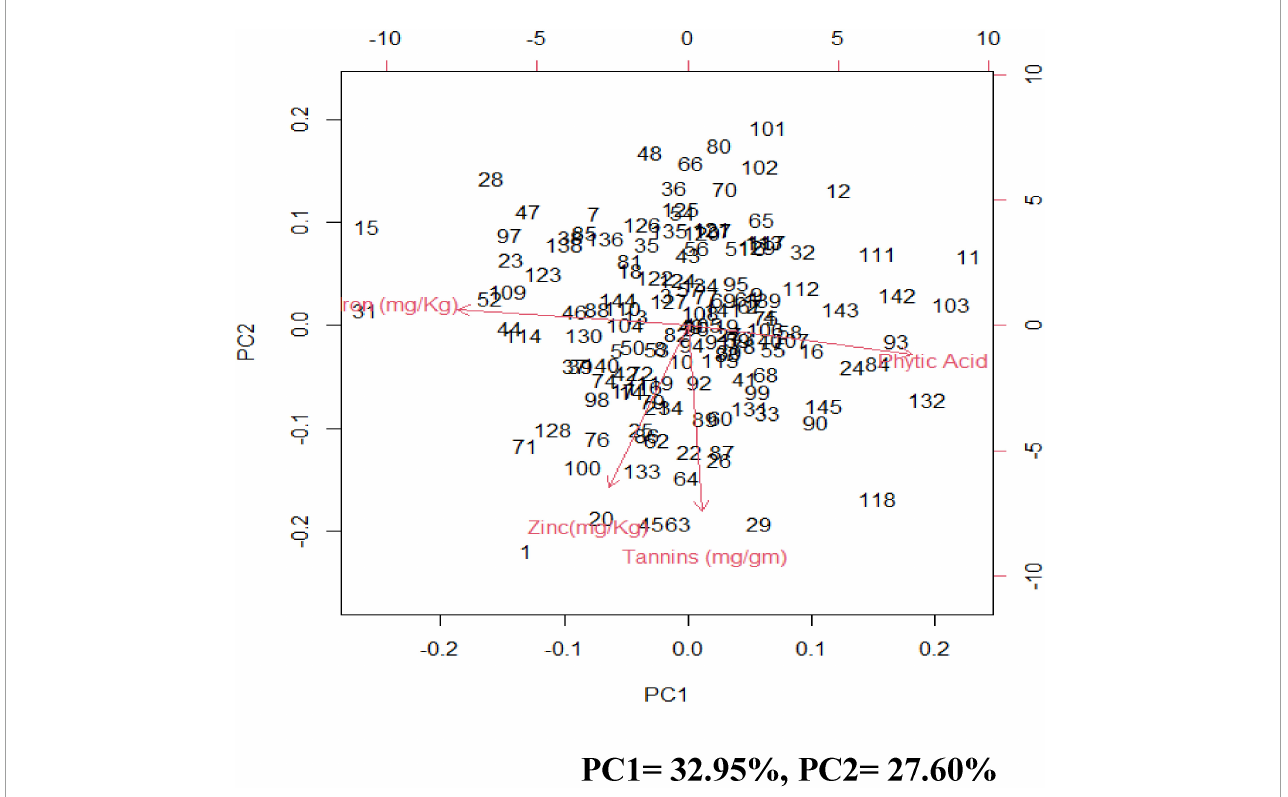
FIGURE3 Biplots of the first two principal components (PC) showing variation among grain iron concentration, grain zinc concentration, grain phytic acid content, and grain tannin